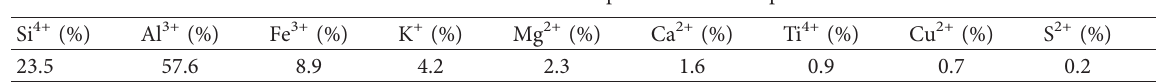
Table 2: Chemical composition of the expansive soil.